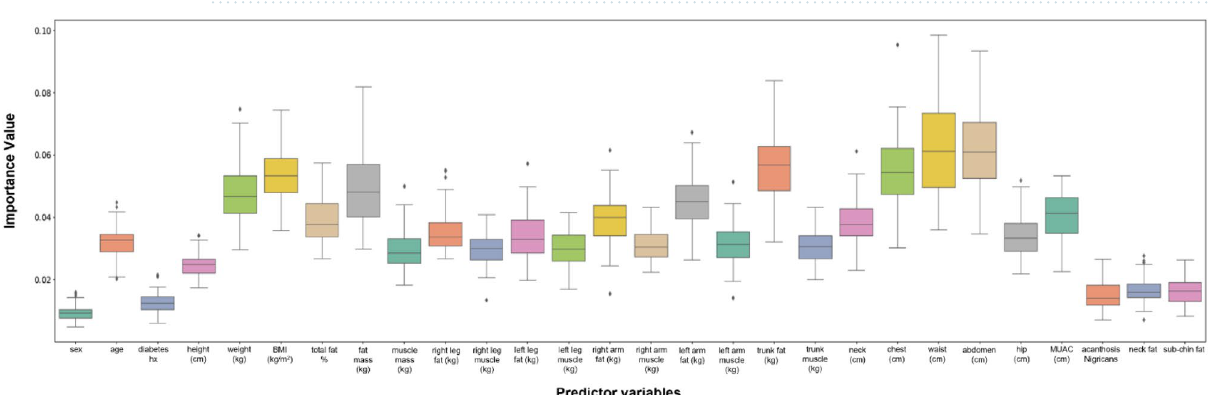
Figure 3. Box plots showing different classification methods applied to the dataset for stages of fibrosis. Box plots are generated by performing 50 individual runs for each classifier. This will assure that the achieved results are reliable.